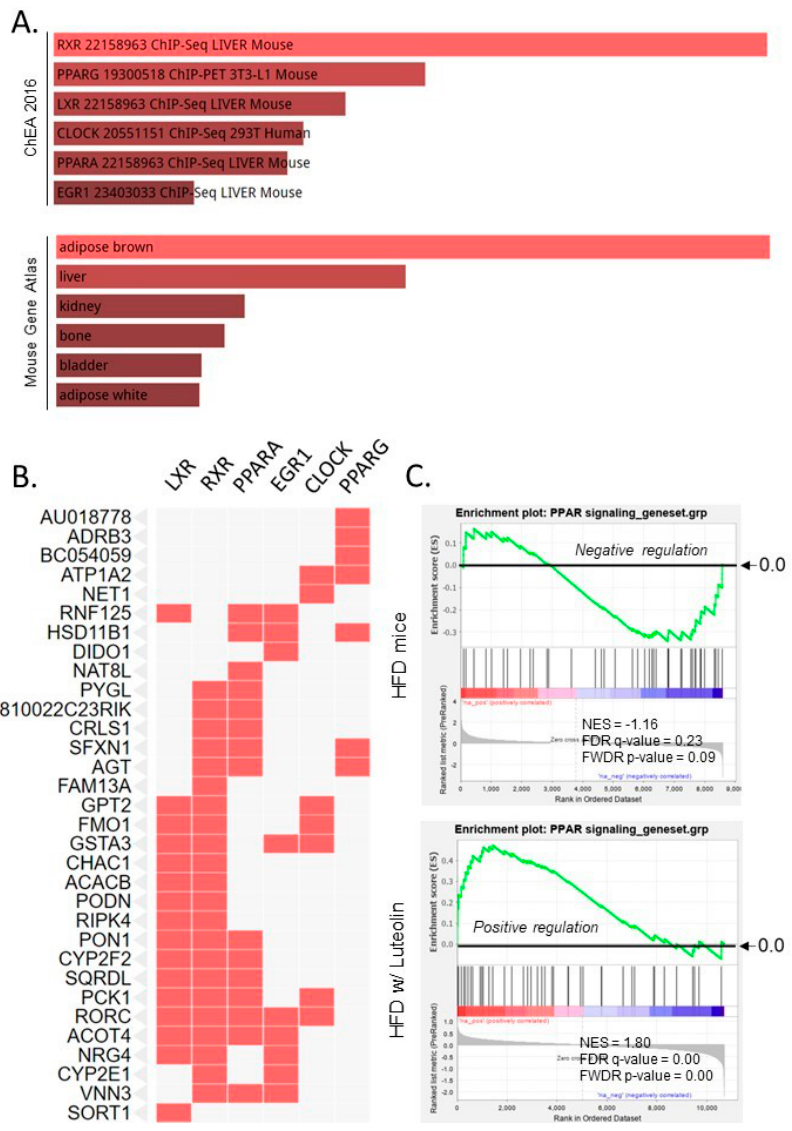
Figure 4. Pathway analysis of downregulated genes in the liver of HFD mice. ( A ) Downregulated NR signaling pathways and genes associated brown adipose tissue based on ChEA and Mouse Gene Atlas database; ( B ) A cluster graph of gene expression profiles of downregulated NR signaling according to ChEA database; ( C ) GSEA profiles of PPAR signaling in HFD with and without luteolin treatment.